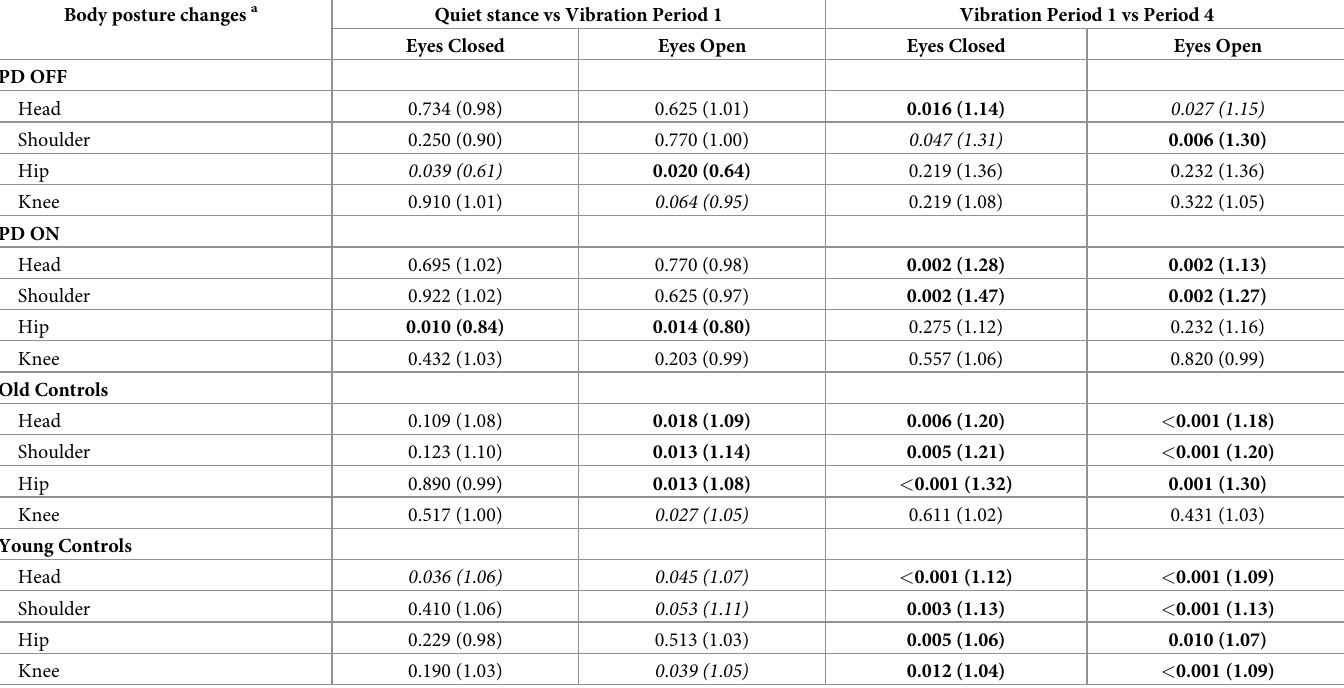
Table 4. Body posture changes between quiet stance and vibration period 1 and between vibration period 1 and period